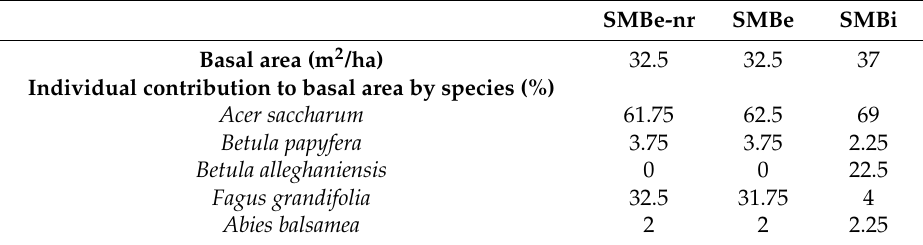
Table 1. Stand composition and tree basal area of the three forest types studied. SMBe-nr SMBe SMBi Basal area (m 2 /ha) 32.5 32.5 Individual contribution to basal area by species (%) Acer